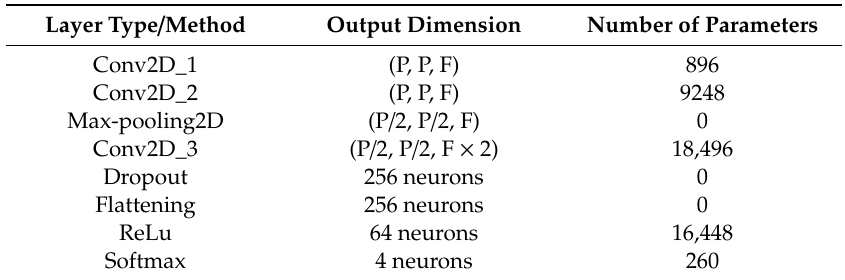
Table 3. Two-dimensional convolutional neural network (2D-CNN) architecture applied in this study. P and F refer to the patch size and number of filters, respectively.